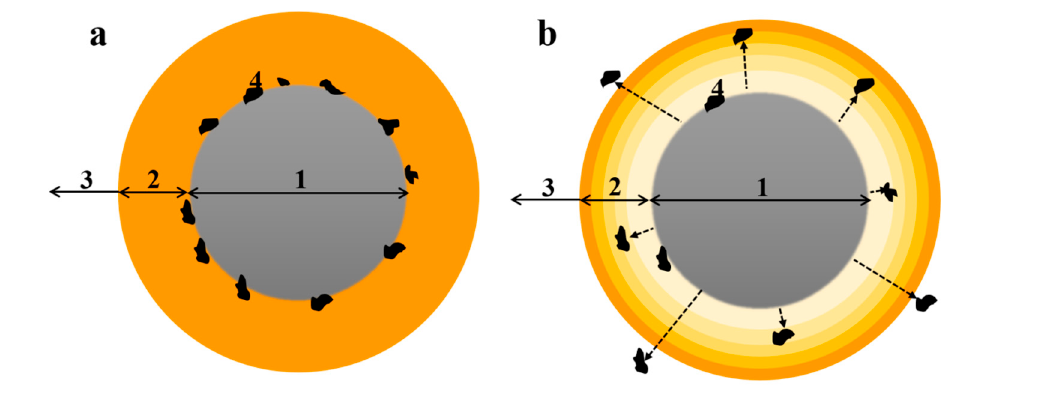
Figure 12. Product layer covers the surface and prevent liquid access to surface in convection-leaching ( a ); The temperature gradient on liquid film causes a mass transfer and reduce the ash layer formation in microwave-leaching ( b ).